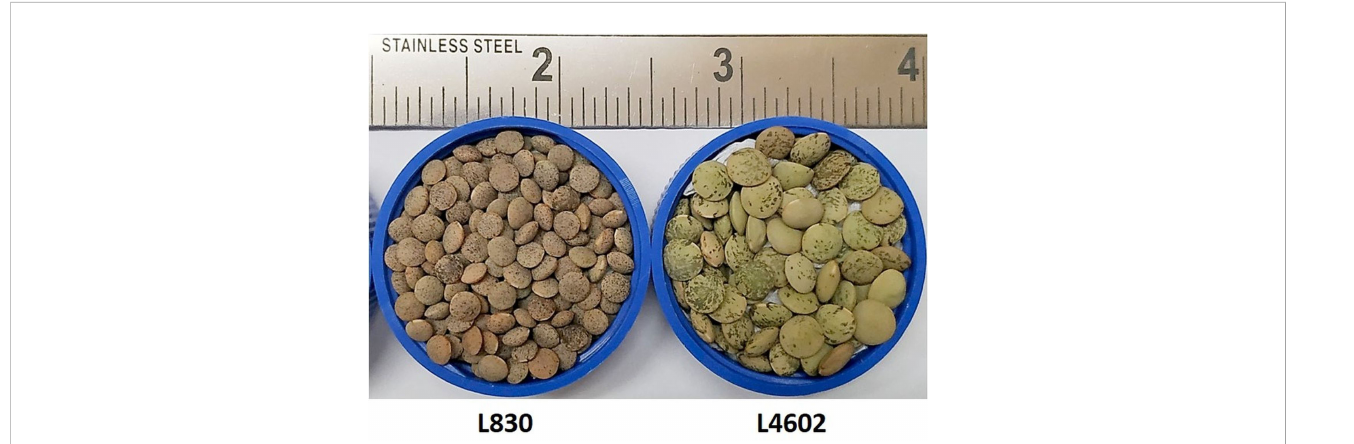
FIGURE 1 Seeds of the small-seeded (L830, mean 1000 seed weight=20.9g) and large-seeded (L4602, mean 1000 seed weight=42.13g) parents were used for the seed size